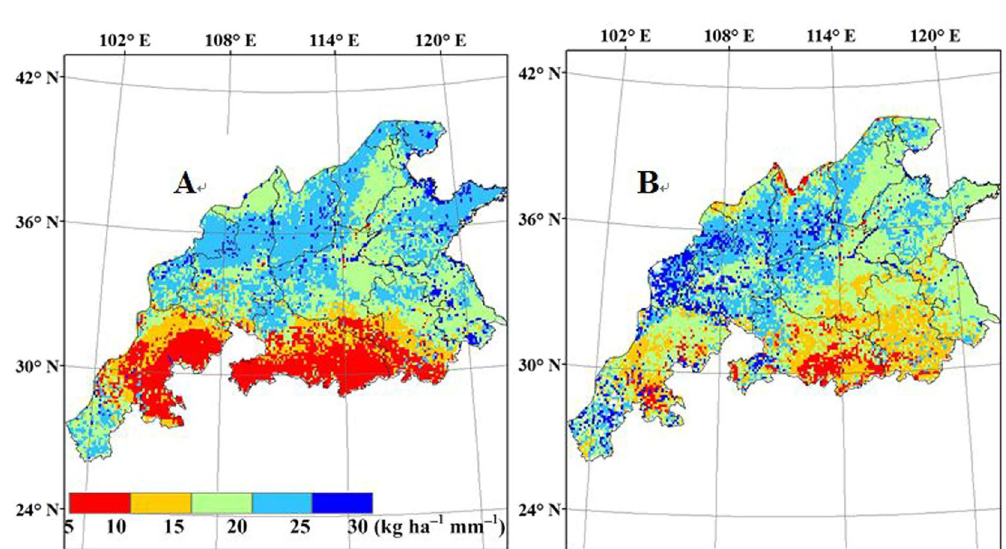
Figure 13. Simulated wheat irrigation water use efficiency (kg ha − 1 mm − 1 ) from 1998 to 2008 in the main production regions of China, ( A ) CERES-Wheat; ( B ) WheatGrow (This figure was created by ArcGIS 9.3, http://